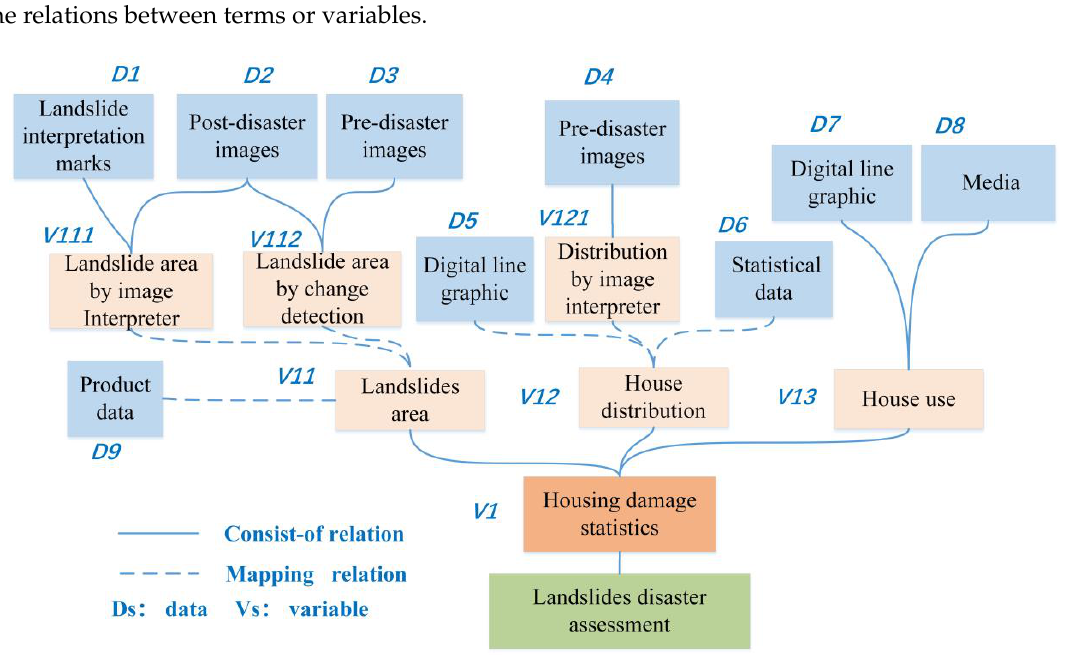
Figure 2. Flowchart of advantageous information selection from the original datasets.